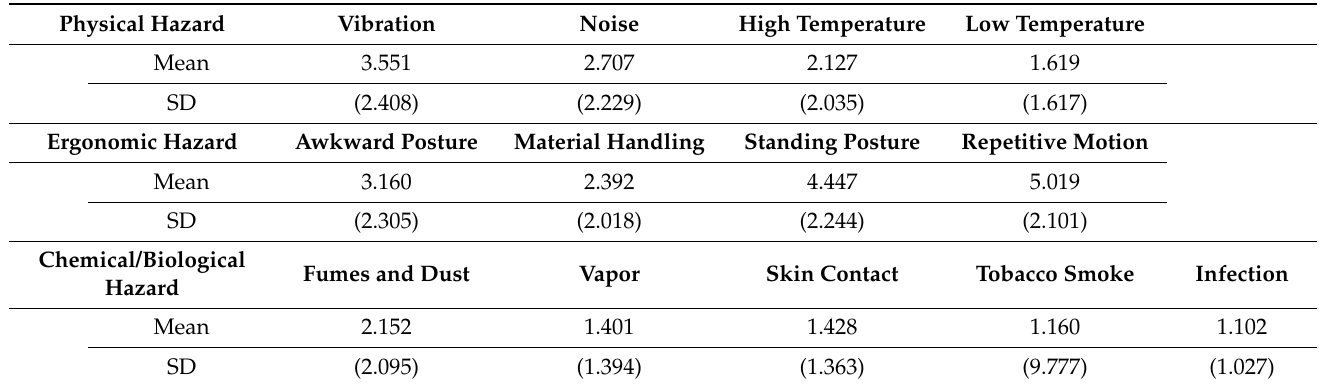
Table 2. Comparison of ADHE of the physical, ergonomic, and chemical/biological